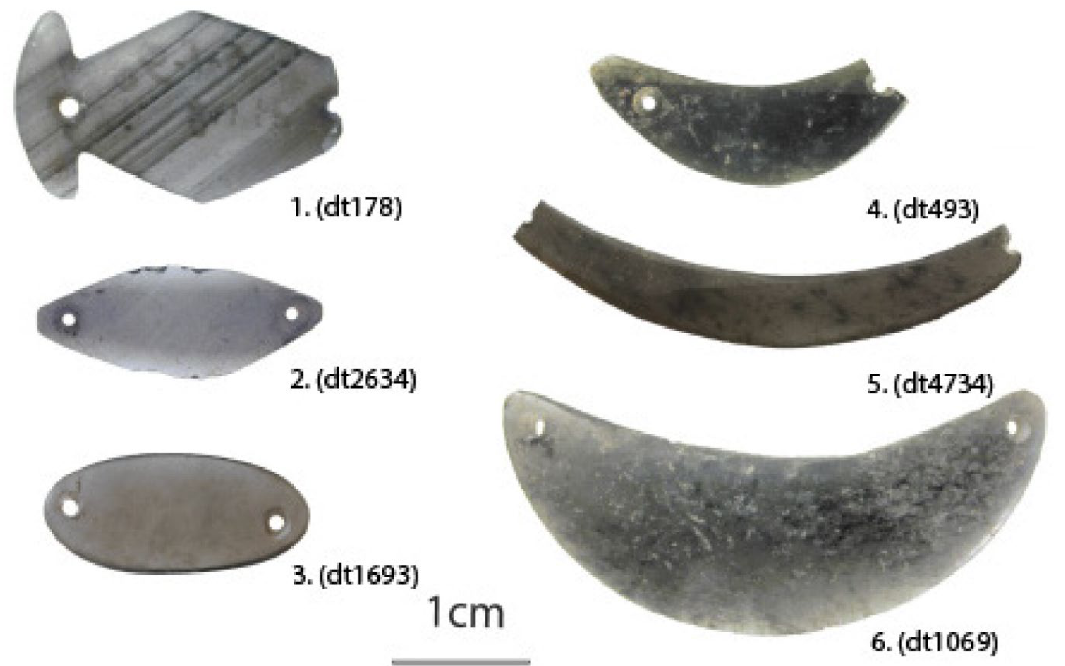
Figure 4. A selection of links from Domuztepe. No. 1 is a unique flanged form; nos 2 and 3 small lozenge shaped and oval forms and nos 4-6 crescentic forms. They are all late Halaf (c. 5800-5300 BCE) in date. Photographs courtesy of Stuart